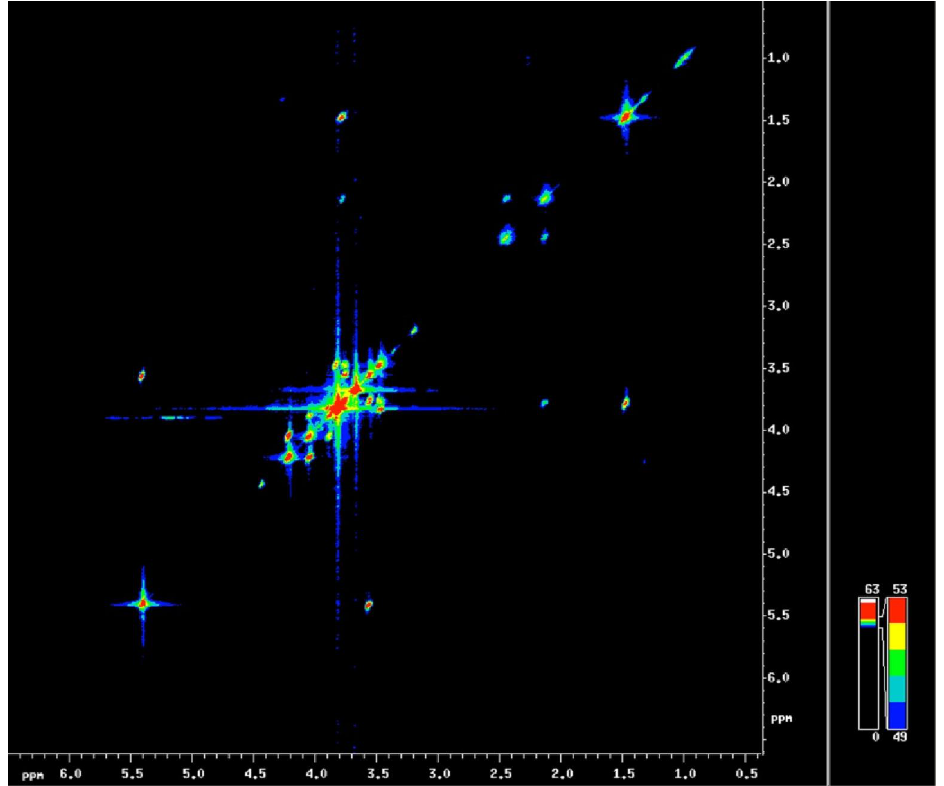
3.4. Double Resonant 1 H / 13 C NMR Allows the Tracing of 13 C Labelled Metabolites within the